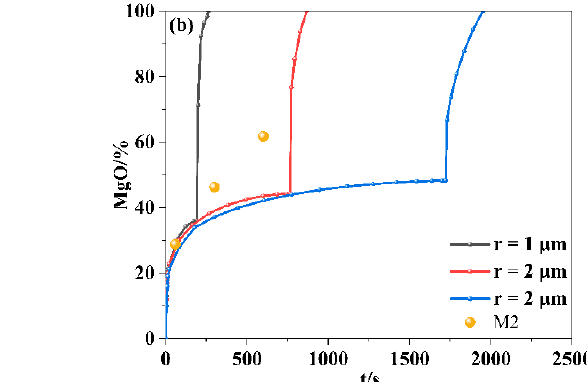
2 O 3 inclusions with different sizes.